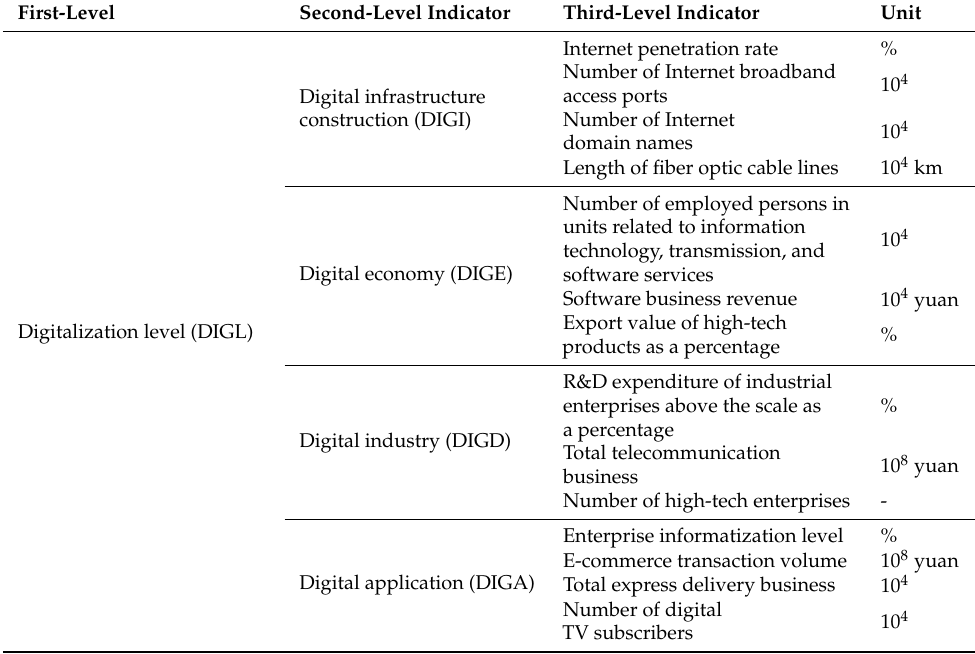
Table 1. Comprehensive quantification system of the digitalization